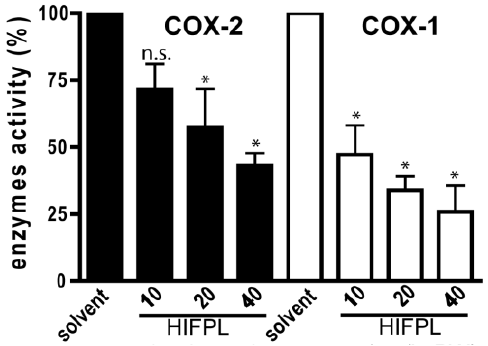
Figure 4. HIFPL inhibited COXs activity in in vitro enzymatic assays. HIFPL was dissolved in DMSO and prepared in three different concentrations (10, 20 and 40 µg/mL). The values are means ± standard errors, * p < 0.05; n.s.: not significant (ANOVA/Dunnett), compared to the solvent-treated group.